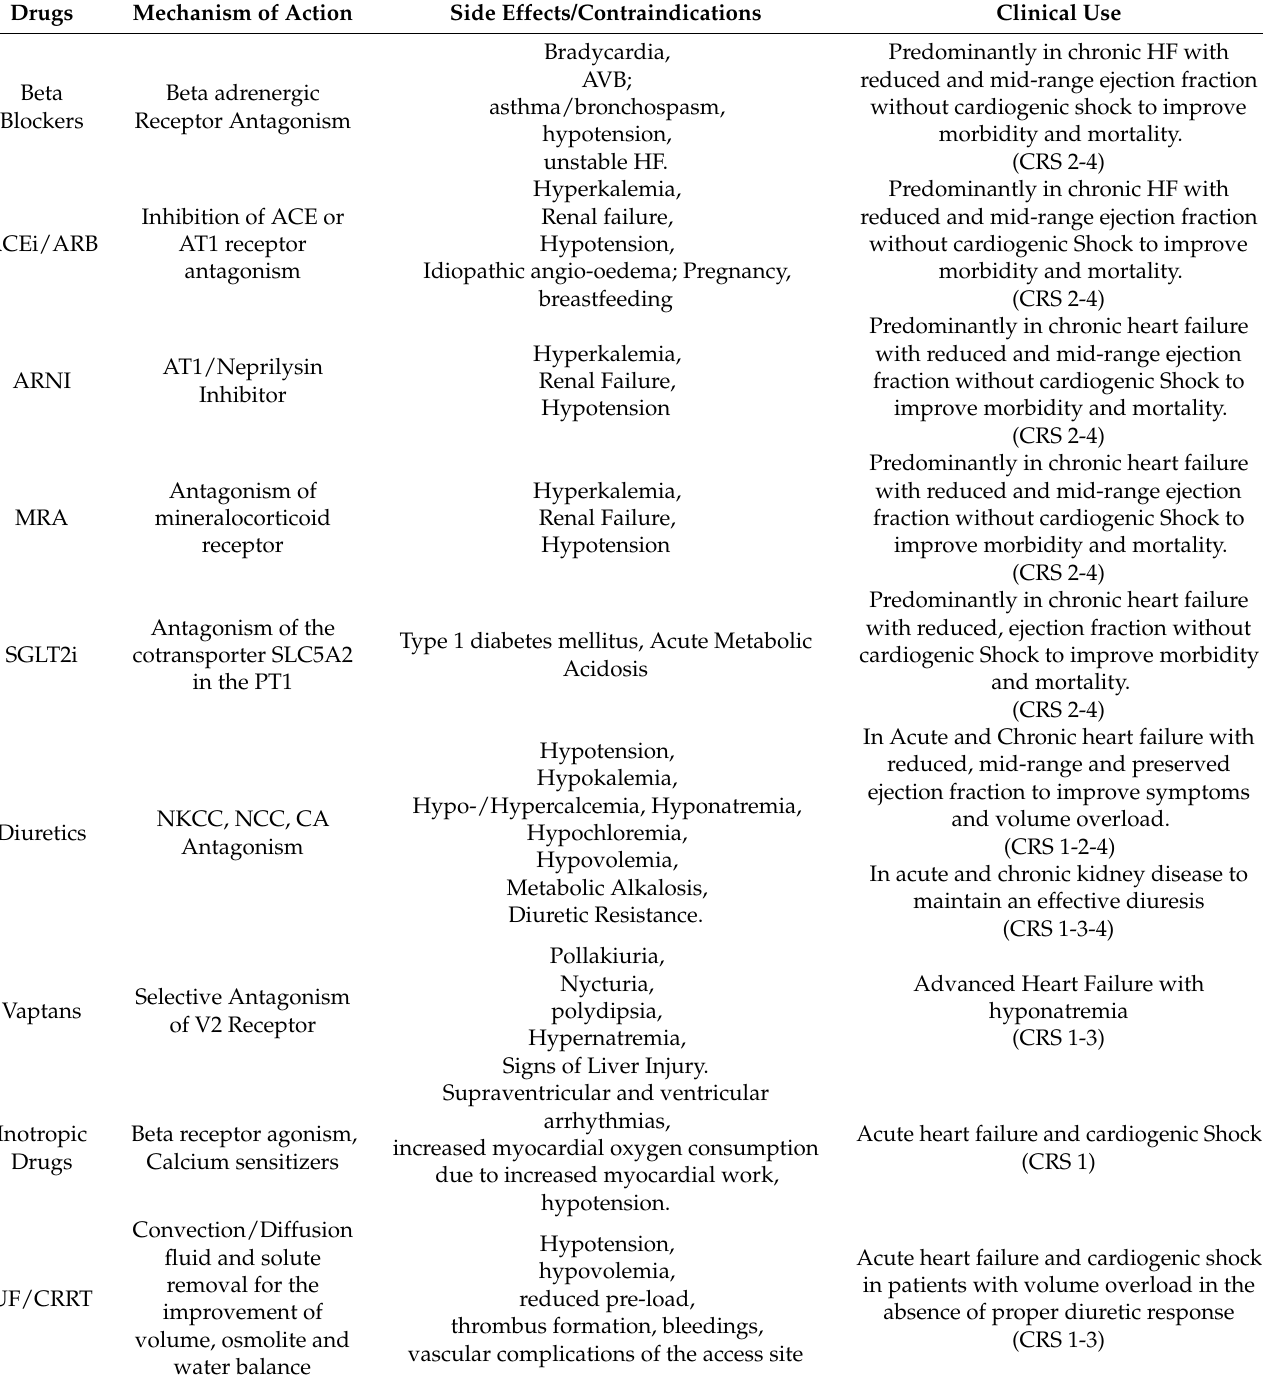
Table 3. Therapeutic approaches for cardiorenal